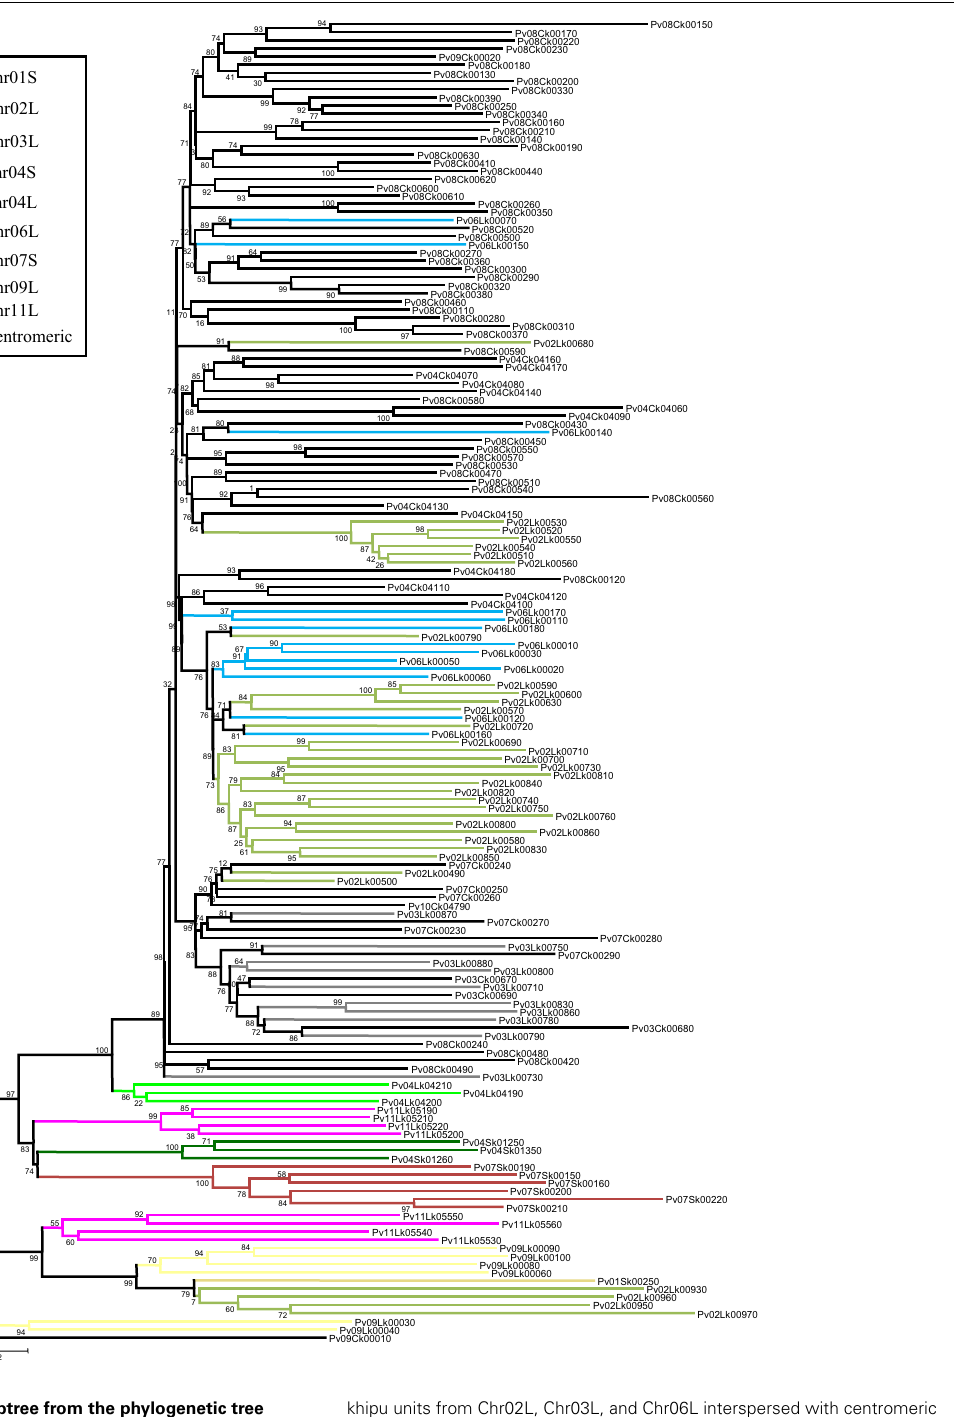
FIGUREA2 | Detailed view of a subtree from the phylogenetic tree presented in Figure 1 containing centromeric khipu units . Branch colors correspond to the colors defined in Figure 1 . Note cases of subtelomeric